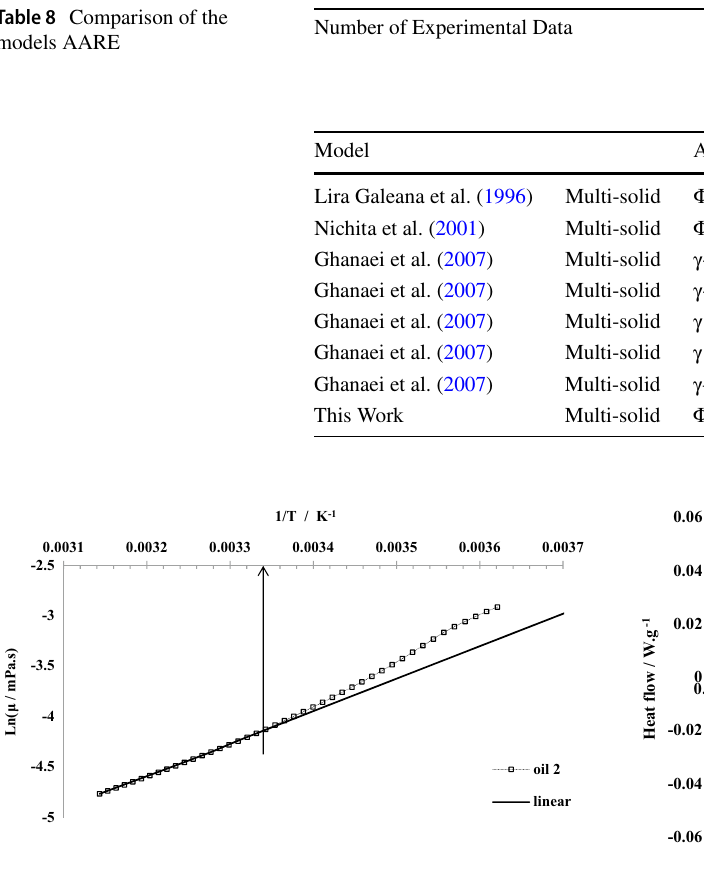
Fig. 8 WDT measurement by viscometry technique for oil #2